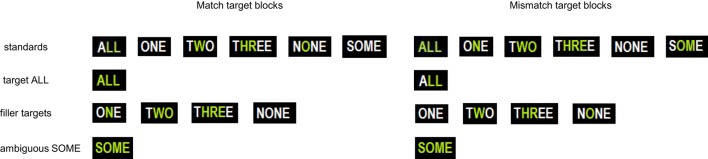
Material used in the ERP experiment (see Section 2.2.2).